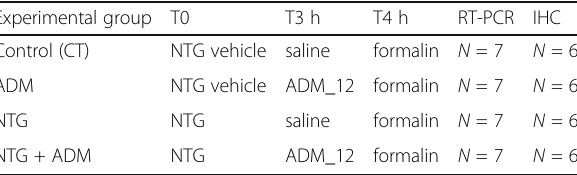
Table 1 Schematic representation of experimental groups, timing (T) of administration and number (N) of animals per group assigned to different experimental set Experimental group